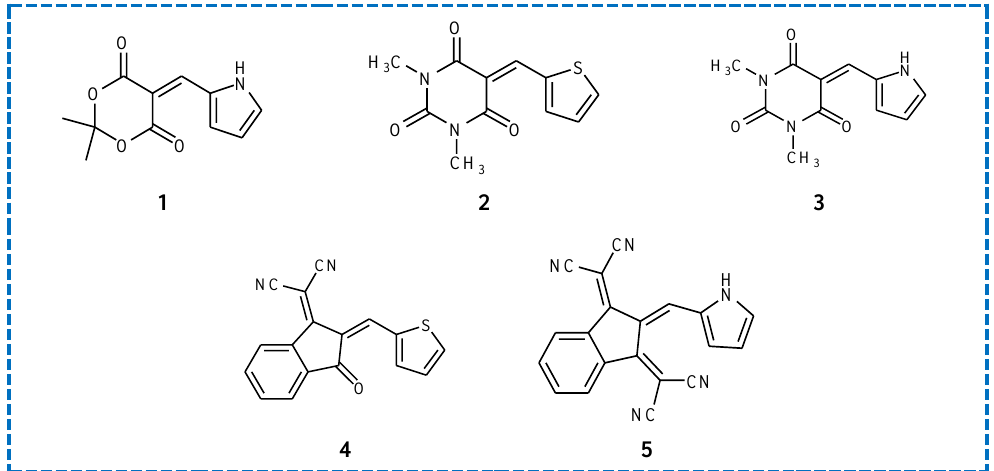
Figure 8. Chemical structures of push – pull sensitizers proposed by Sun and colleagues [75].